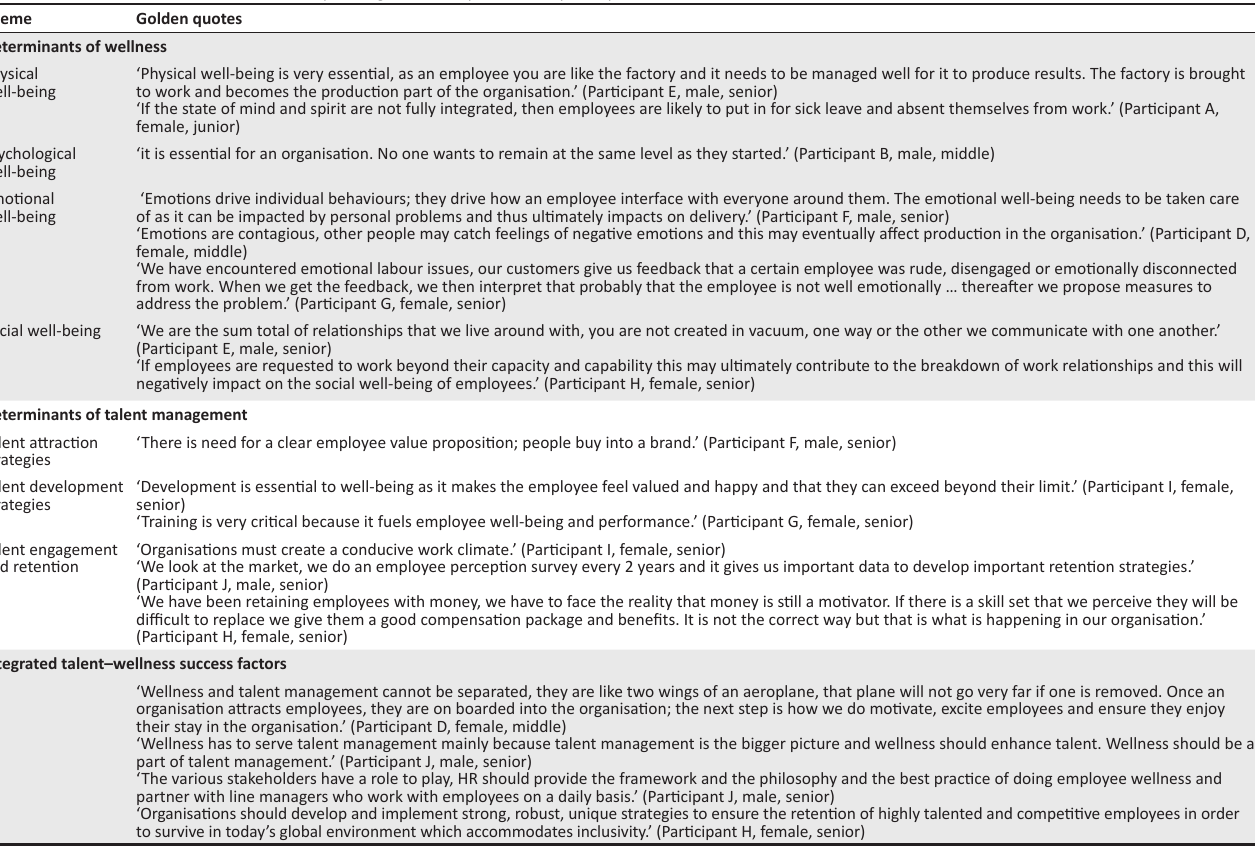
TABLE 2: Themes and subthemes with corresponding evidence quotes from